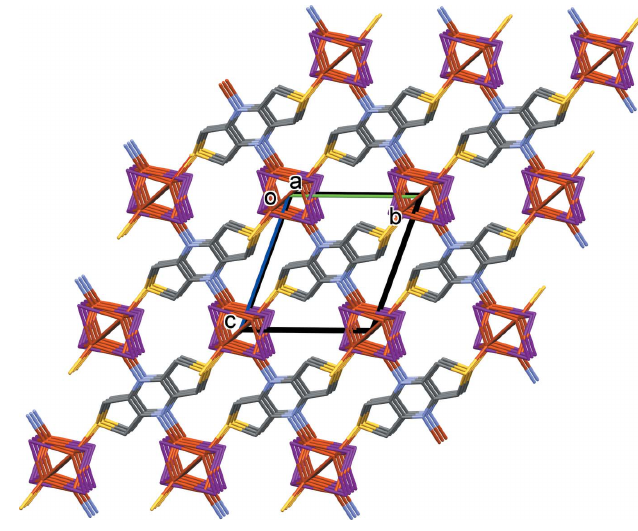
Figure 1 A partial view of the molecular structure of complex I , with atom labelling for the atoms of the asymmetric unit. Displacement ellipsoids are drawn at the 30% probability level. Colour code: Cu1 orange, Cu2 green, I1 purple, I2